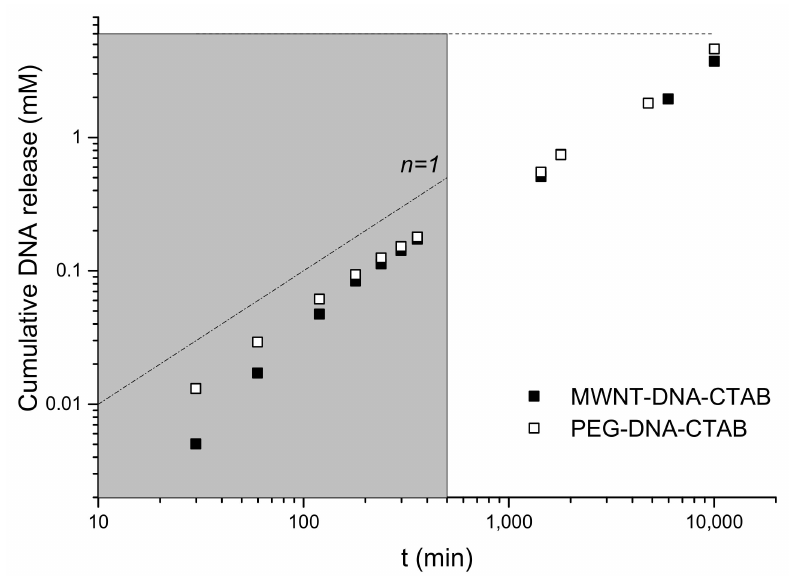
Figure 3. Cumulative released DNA concentration as a function of time in pH = 2 solutions. The dashed line corresponds to the maximum DNA concentration what can be released. The gray area shows the fast release